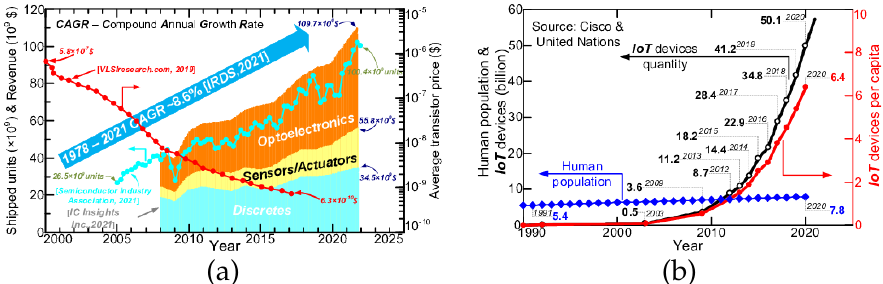
Figure 1. ( a ) History of the semiconductor industry underlining fabrication capability boost [1] (blue line), cost reduction [2] (red line), CAGR [3] (blue arrow), revenue per selected branch [10] (bar plot); ( b ) historical comparison of IoT nodes quantity [5] (black line) with human population [11] (blue line), highlighting the IoT devices per capita (red